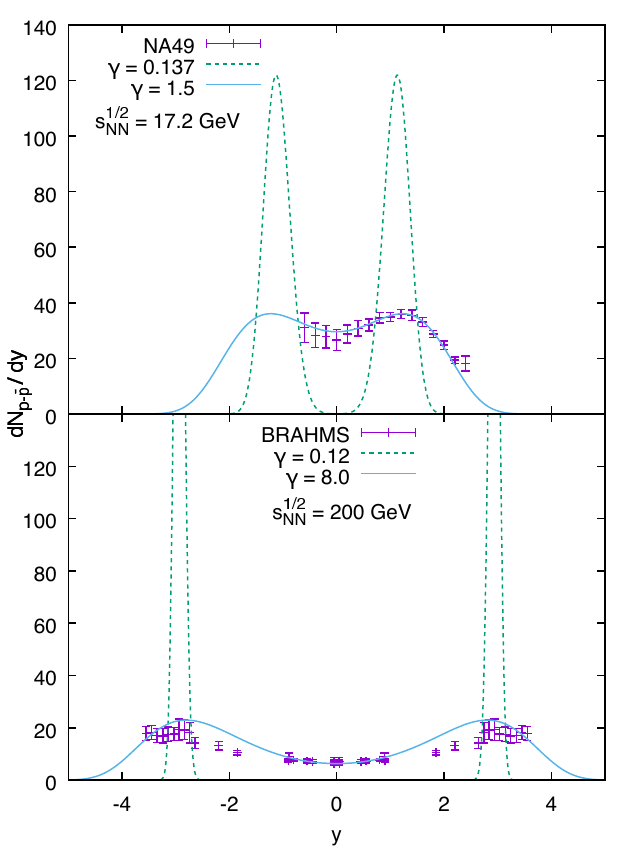
Figure 3. Comparison of the linear ( q = 1) model without (dashed) and with (solid) adjusted di ff usion √ s NN = 17 . 2 GeV [2], upper frame, and with BRAHMS term with NA49 data for 0-5% central PbPb at √ s NN = 200 GeV [3], lower frame. The values of the dimensionless di ff usion data for central AuAu at strengths are γ = 0 . 137 and 0 . 12 from the fluctuation-dissipation relation (see text), whereas γ = 1 . 5 and 8 . 0 are adjusted to the SPS and the RHIC data, respectively, and account also for collective expansion. The values of the freeze-out time have been adjusted in both cases. A numerical solution of the nonlinear di ff usion equation with q > 1 does not fit the data for any value of γ and time. From